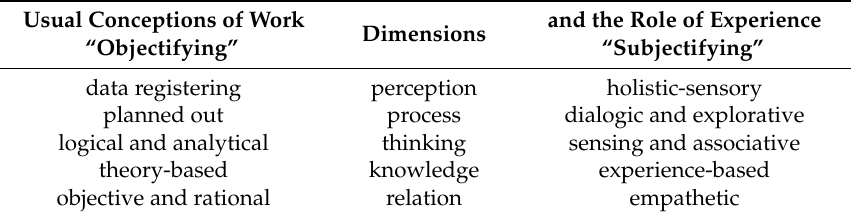
Table 1. Dimensions of subjectifying and objectifying work